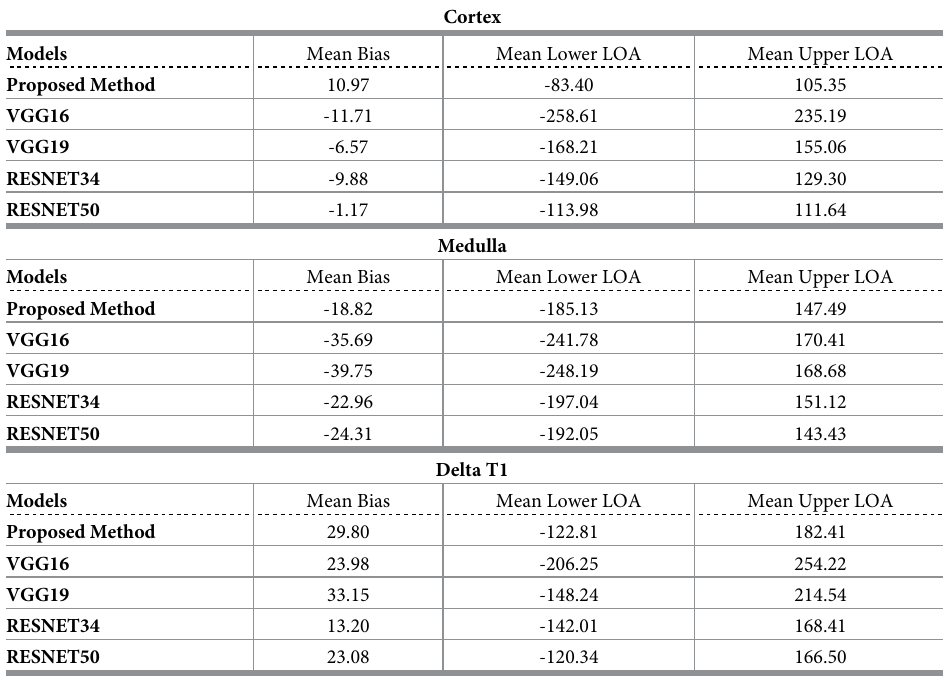
Table 3. The BA plots statistical values for the gold standard manual ROIs [4] and the proposed RCM U-Net, [15], standard VGG16 [11], VGG19 [17], ResNet34 [18], and ResNet50 [19] automatically measured cortex, medulla and Δ T1